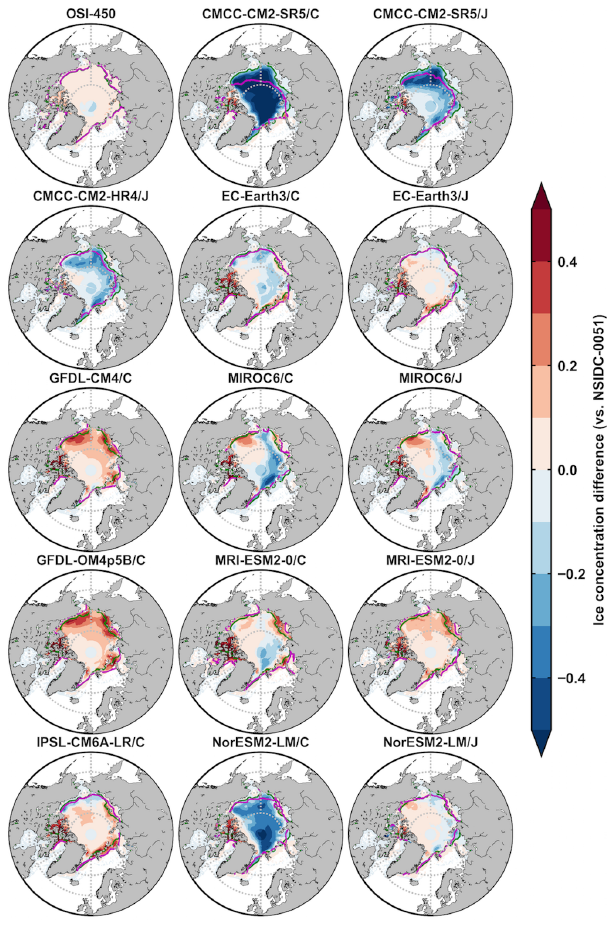
Figure A1. The 1980–2007 September mean Arctic ice concentra- tion differences between OSI-450/model outputs and the NSIDC- 0051 data (colors), and contours of 15% concentration of the NSIDC-0051 data (green lines) and OSI-450/model outputs (ma- genta lines). The second and third columns are from the five OMIP1 and OMIP2 model outputs of CMCC-CM2-SR5, EC- Earth3, MIROC6, MRI-ESM2-0, and NorESM2-LM, respectively.